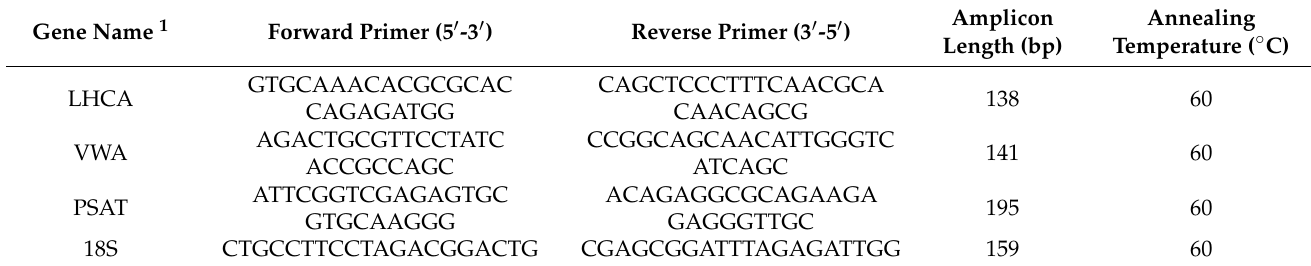
Figure 3. Volcano plots of differentially expressed transcripts (red indicates upregulation and blue indicates downregulation) between ( a ) WL and BL, ( b ) WL and GL, ( c ) WL and RL, and ( d ) without and with CO 2 enrichment, at an adjusted p -value < 1 × 10 − 10 and a log 2 fold change ≥ 2. WL, white light; BL, blue light; GL, green light; RL, red light. Table 3. Selected genes and list of primers used for real-time PCR